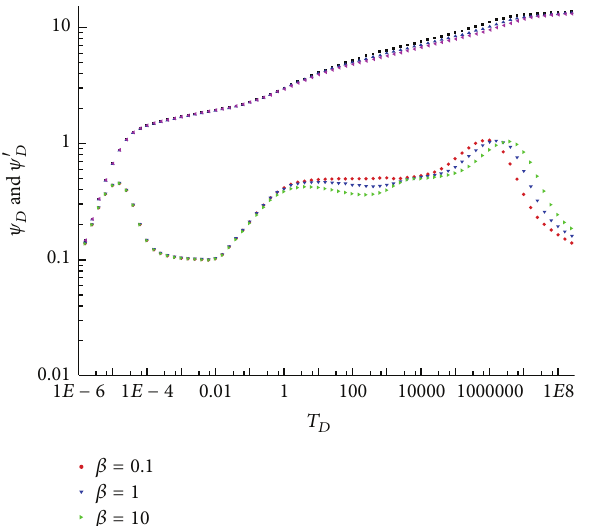
Figure 10: Influence of 𝑍 𝑤𝑑 on thebottom-holepressurewith mixed boundary ( 𝜔 = 0.01 , 𝜆 = 300 , 𝛽 = 50 , 𝐿 𝐷 = 2.5 , 𝐶 𝑑 = 0.0001 , 𝑠 = 1 , and 𝑟 𝑒𝐷 = 50 ).